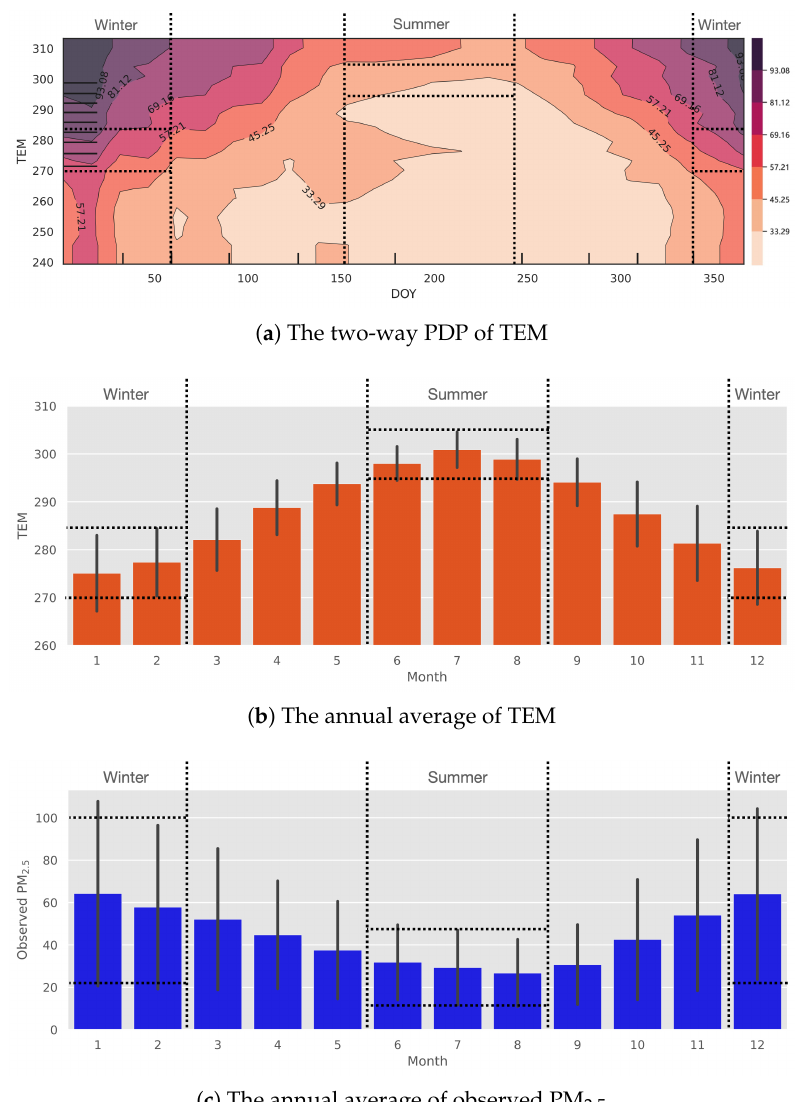
Figure 7. ( a ) The two-way partial dependence plots (PDP) of temperature (TEM) for the GTJC model. The contour lines represent the average estimated PM 2.5 concentrations ( µ g m − 3 ). The black bars on the axes show the deciles of the feature values in the training data. ( b ) Mean values of the TEM at a monthly scale. ( c ) Mean values of the PM 2.5 concentrations at a monthly scale. The error bar referred to the standard deviation of the data